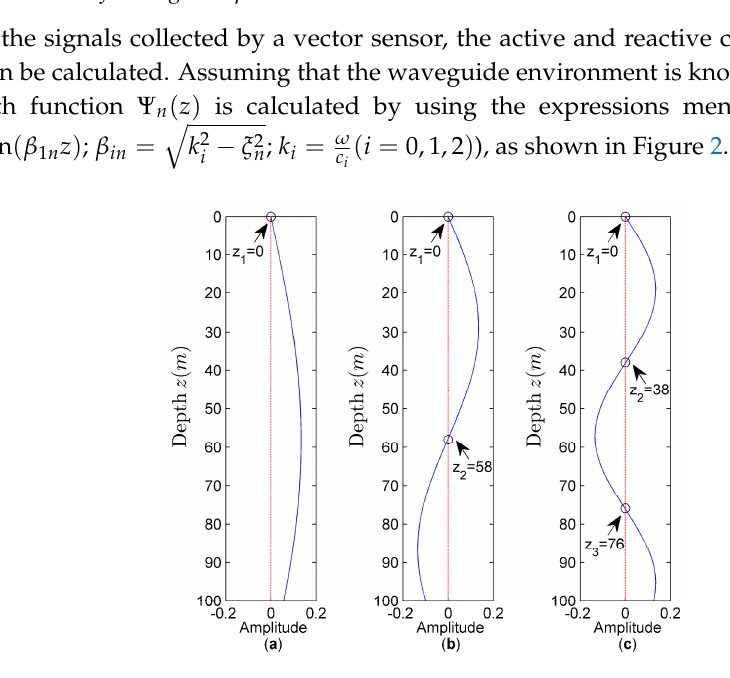
Figure 2. Mode depth function amplitude distribution. ( a ) First normal mode; ( b ) Second normal mode; ( c ) Third normal mode.